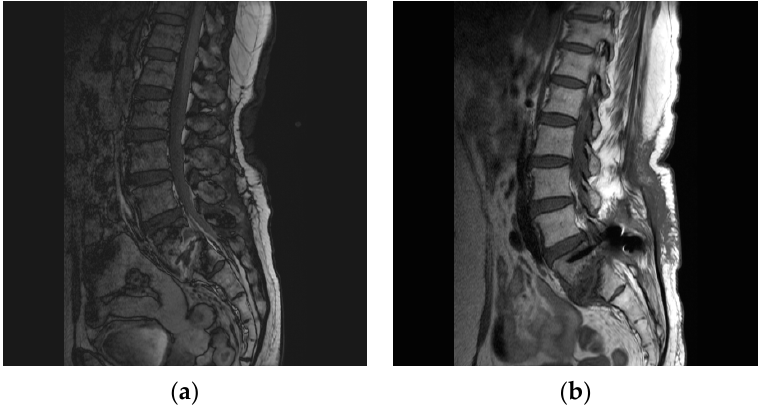
Figure 1. Spine magnetic resonance imaging (MRI) showing infectious spondylitis of L5-S1 with epidural enhancement at the L4-S1 level with decreased disc height and bone marrow signal change before treatment ( a ) and improvement of fluid collection with no newly developed bony destructive change at and around the L5-S1 level ( b ).